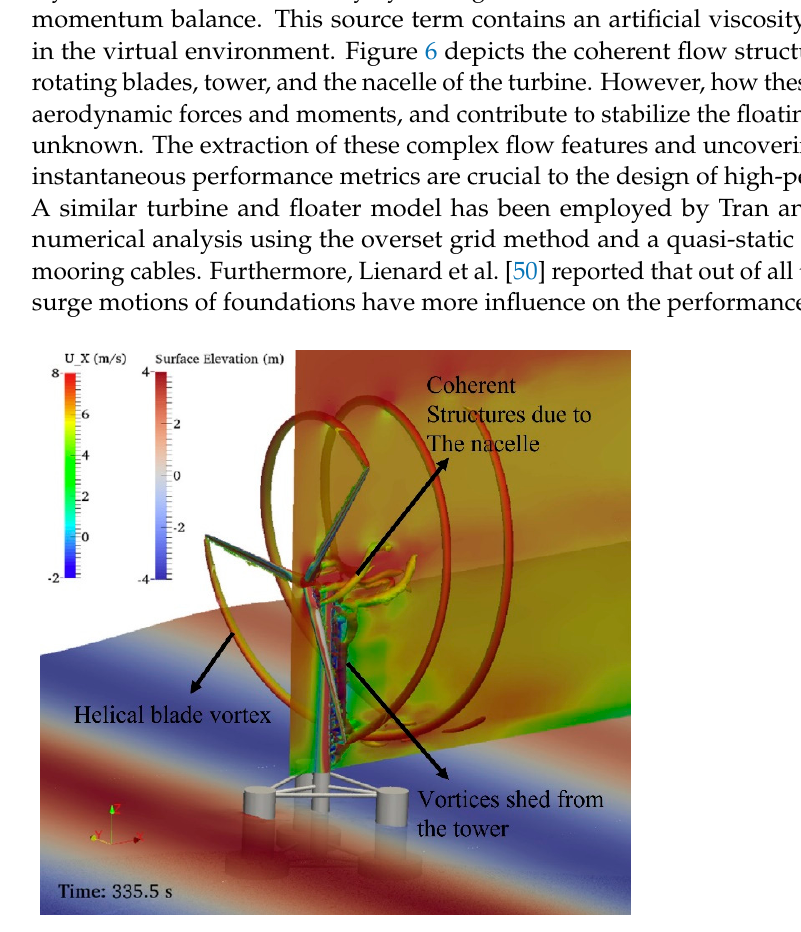
Figure 6. Coherent structures around a floating offshore wind turbine [19].